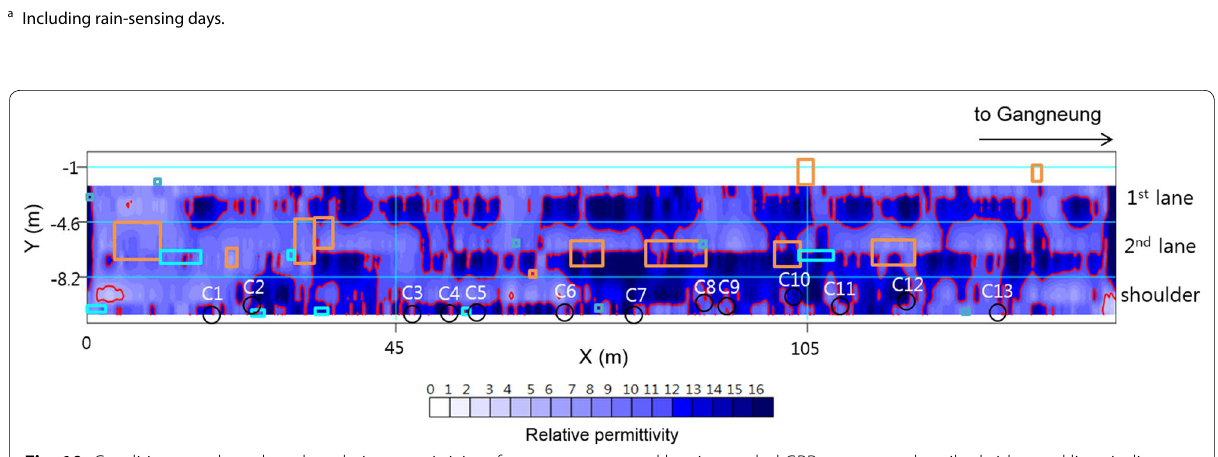
Weather data from Korea Meteorological Administration (KMA) for 30 days prior to the survey date (September 12, 2007–October 10, 2007). a Including rain-sensing days.